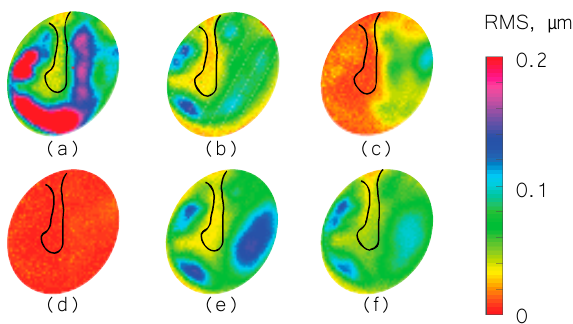
Figure 4. Root mean square (RMS) of TB3 displacement under different conditions. ( a ) Open cavity; ( b ) closed cavity; ( c ) half fluid in contact; ( d ) full fluid in contact; ( e ) stapes immobilization; and ( f ) IS joint interruption.